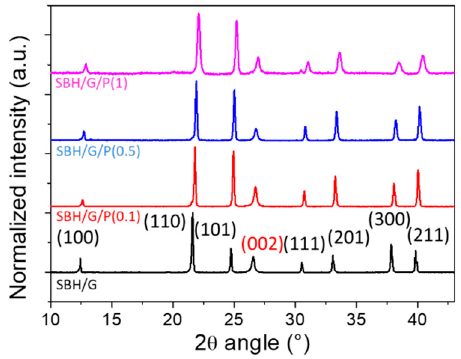
Figure 3. XRD diffractograms of the prepared samples. Miller indices are depicted in black for SBH and in red for graphite crystal planes. Intensity is normalized on the SBH (110) peak.